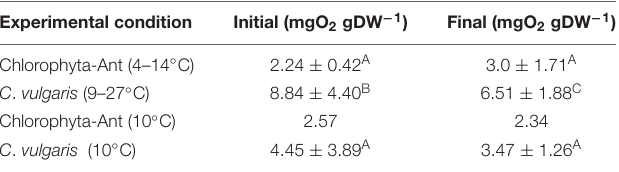
TABLE 3 | Excess dissolved oxygen normalized with corresponding measured biomass dry weight. Experimental